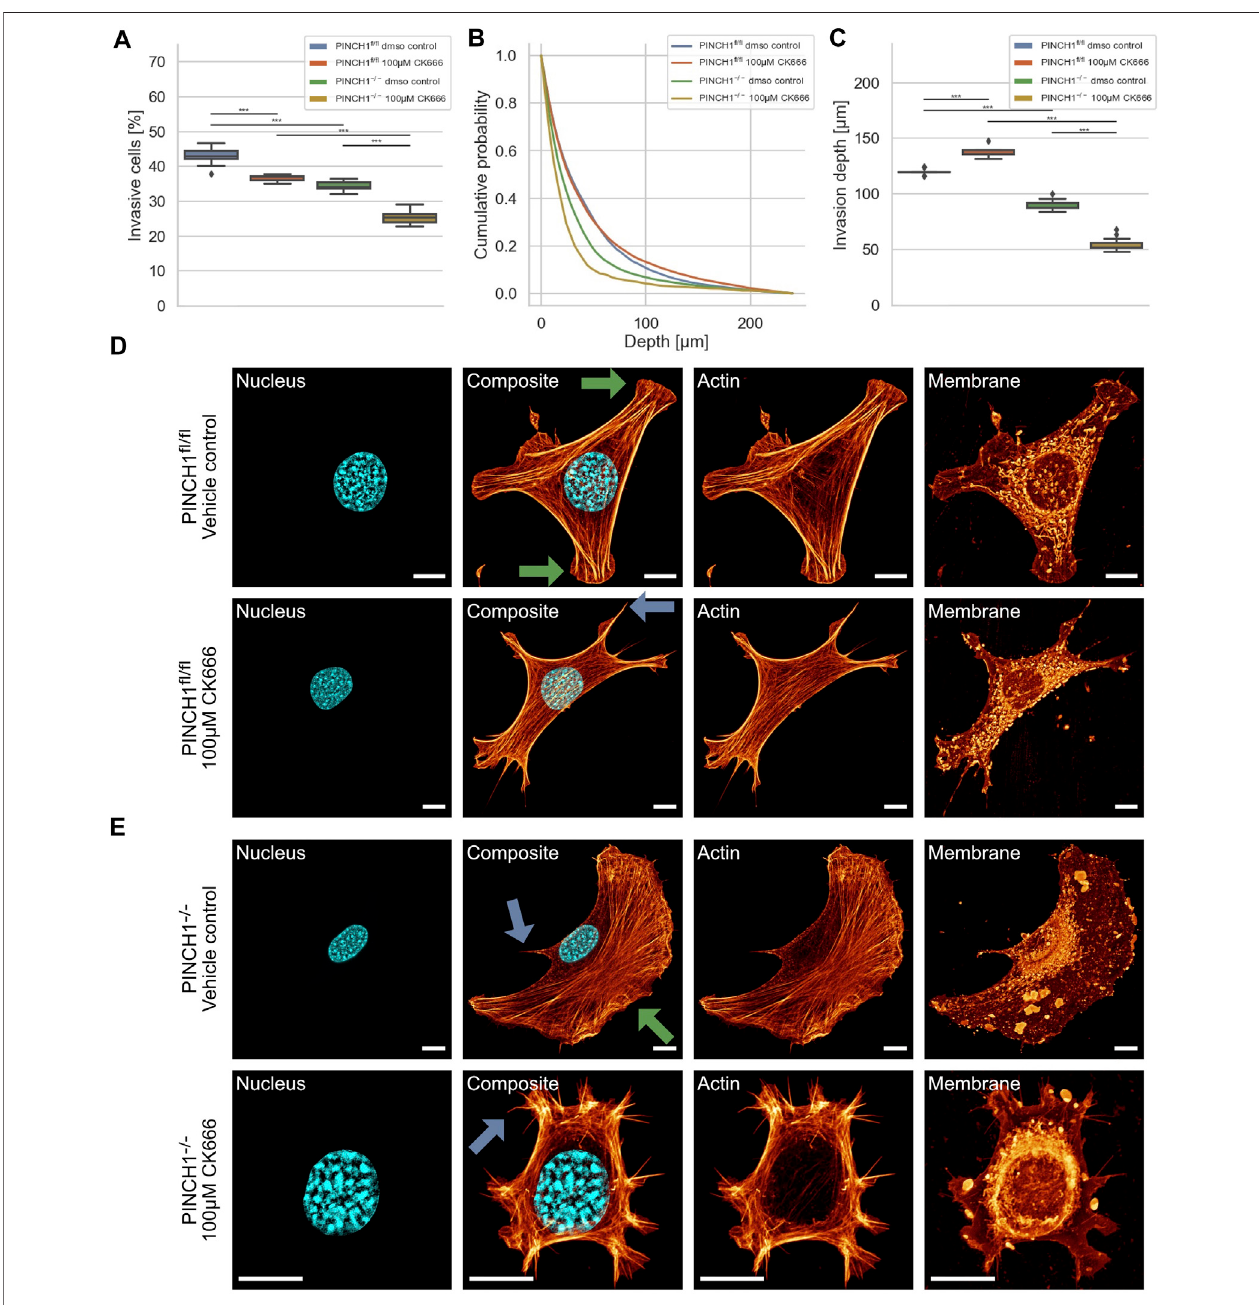
FIGURE 7 | 3D collagen invasion of PINCH1 − / − and PINCH1 fl / fl cells in the presence of absence of CK666 treatment. (A) Average percentage of invasive migrating PINCH1 − / − cells (yellow, n = 46,199 cells with CK666; green, n = 435,330 buffer-treated control cells) is pronouncedly decreased compared to PINCH1 fl / fl cells (red, n = 538,616 cells with CK666; green, n = 322,738 buffer-treated control cells) after CK666. The CK666-treatment caused a reduction in the percentage of invasive cells compared to their buffer-treated controls. (B) Invasion depth pro fi les of the invasive PINCH1 − / − cells (green, n = 341,487 cells in the absence, yellow, n = 52,325 cellsinthepresenceofCK666) andinvasivePINCH1 fl / fl cells(blue, n =338,771cellsintheabsence,red,n=141,729cellsinthepresenceofCK666)thatweremigrated inthe3Dextracellularmatricesafterthreedaysofcultureat37 ° C,95%humidityand5%CO 2 inthepresenceandabsenceofCK666. (C) TheinvasiondepthsofCK666- treatedPINCH1 − / − cellsismostpronouncedlyimpaired comparedtoCK666-PINCH1 fl / fl cells.Moreover,theaverageinvasiondepths ofPINCH1 − / − cells(green column) is pronouncedly lower compared to PINCH1 fl / fl cells (blue column) either in the presence or absence of CK666. (A,C) data are presented as box and whiskers plots (Q2 represent mean values). (D,E) Confocal laser scanning images are presented as maximal projections. Inhibition of the Arp2/3 complex by CK666 alters the morphology and the actin cytoskeleton of PINCH1 fl / fl cells (D) and PINCH1 − / − cells (E) using a confocal laser scanning microscopy. Cells were cultured on planar substrates coated with 10 μ g/ml laminin and treated for 2 hours with CK666. After fi xation, the cells were stained with Alexa Fluor 546 phallodin, Hoechst and DiD. Nuclear shape, composite of nuclear shape and action cytoskeleton, actin cytoskeleton and membrane shape of a representative PINCH1 fl / fl cell (D) or PINCH1 − / − cell (E) in absence (upper row) and presence of CK666 (lower row) is provided. (D,E) Blue arrows indicate lamellipodia, green arrows indicate fi lopodia. All experiments are conducted in quadruple or quintuple. All scale bars are 10 μ m. (*** p < 0.001; Kruskal-Wallis test).